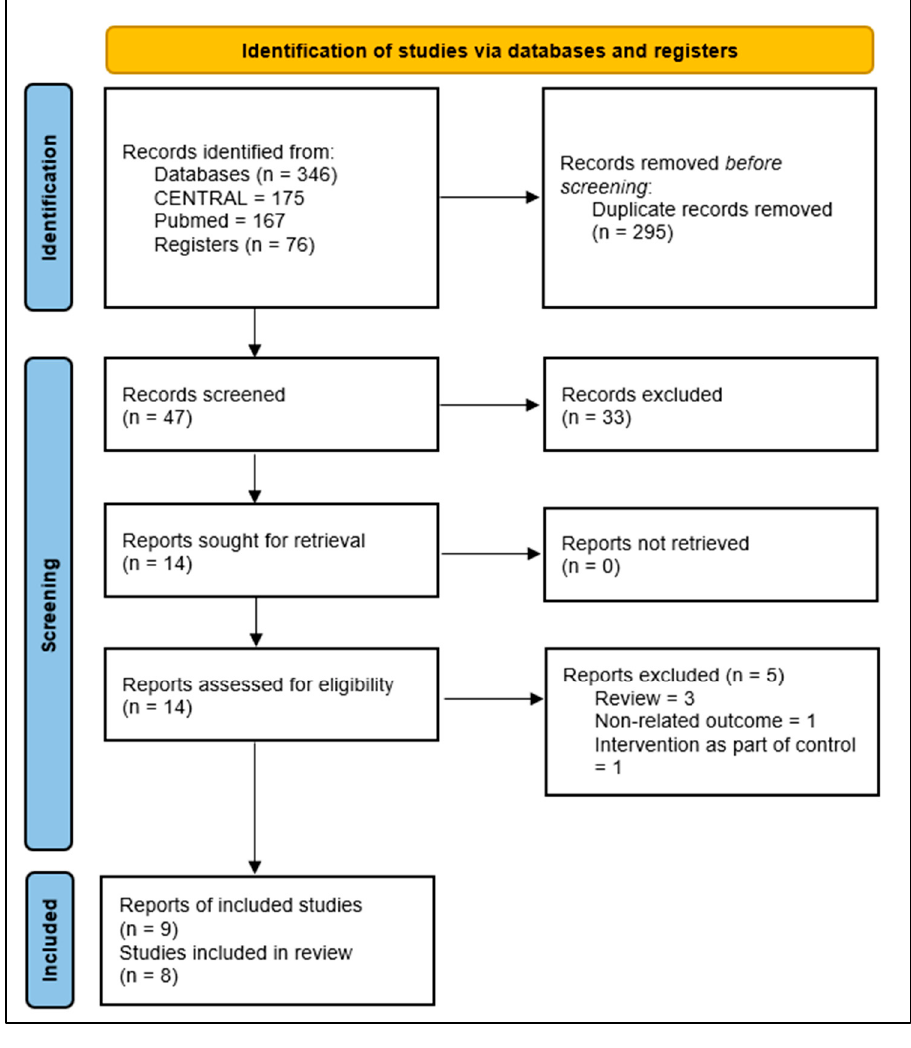
Figure 1. PRISMA flow chart.